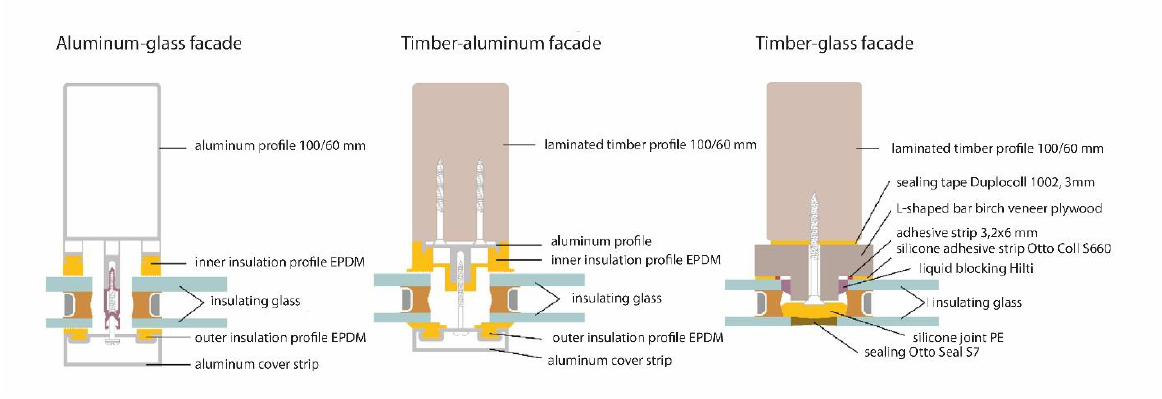
Fig. 7 Overview of the examined façades: aluminum-glass-facades, timber-aluminum- façades and one variant of the timber-wood concrete-glass façades with an L-shaped bar (birch veneer plywood). Own representation based on (Pascha & Winter, 2016). Due to the fact that the choice of glazing for transparent components has a rather minor influence on the life cycle assessment and that the glazing has very similar specifications for the different facade constructions, the insulating glass unit (IGU) was excluded from the life cycle assessment